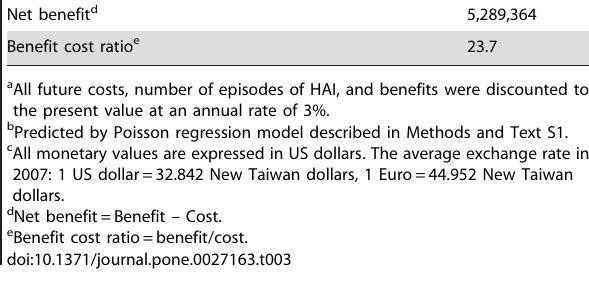
Table 3. Results of Cost-effectiveness Analysis and Cost- benefit Analysis of the Hand Hygiene Program a